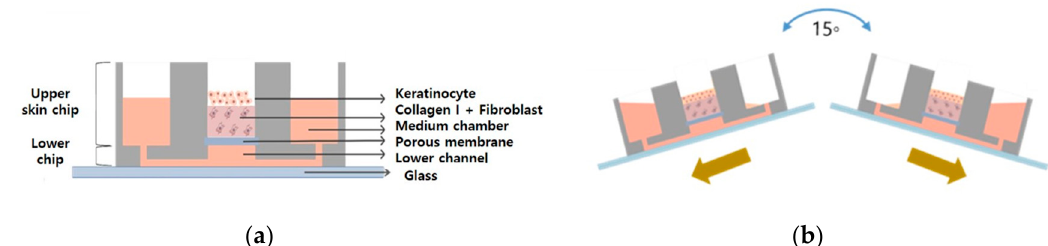
Figure 11. Schematic illustration of ( a ) the pumpless-skin-on-a-chip and ( b ) gravity flow directions by using the gravity flow